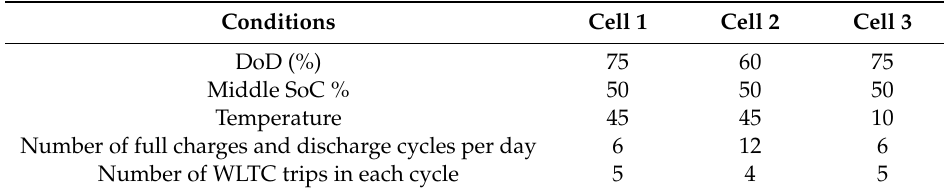
Table 2. Cell aging test conditions.